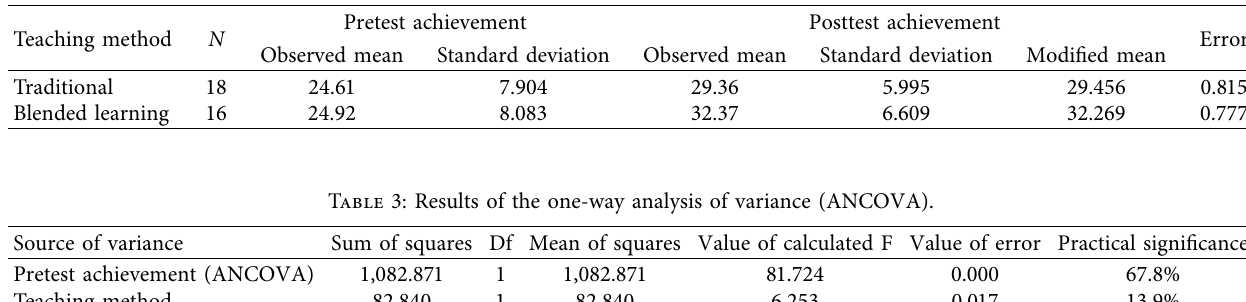
Table 2: Arithmetic observed and modified means of pre- and post-English language tests.